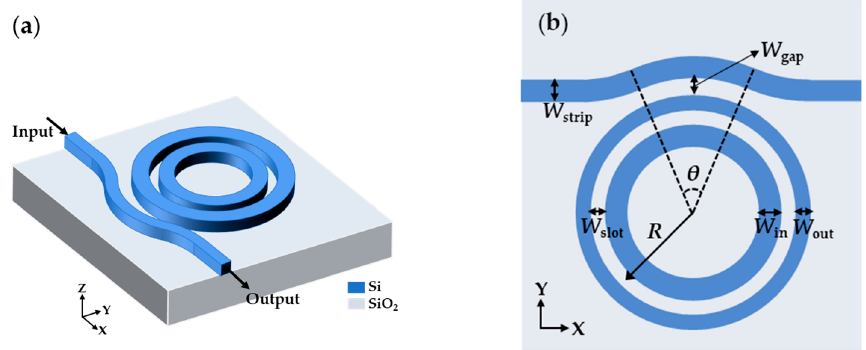
Figure 1. ( a ) Schematic of SMRR sensor. ( b ) Top view of the device.